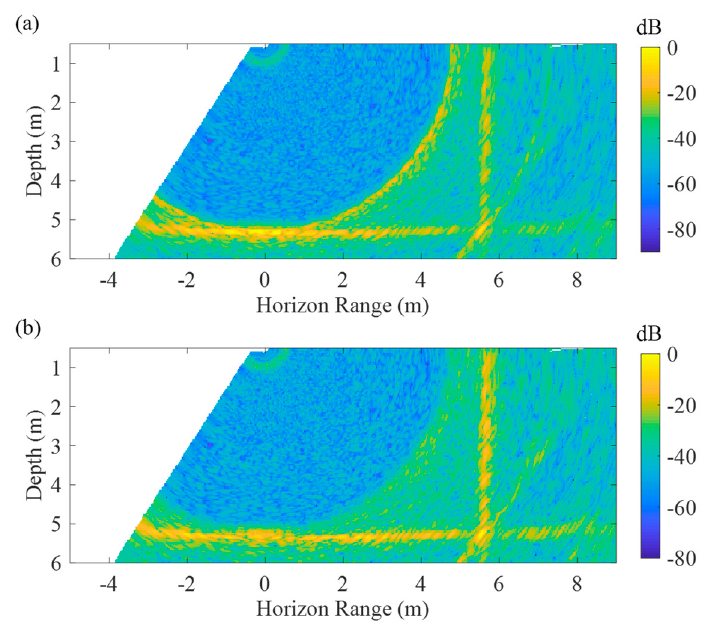
Figure 6. The WCIs containing gas emissions, obtained by the conventional beamformer (CBF) beamformer ( a ) and MVDR beamformer ( b ).